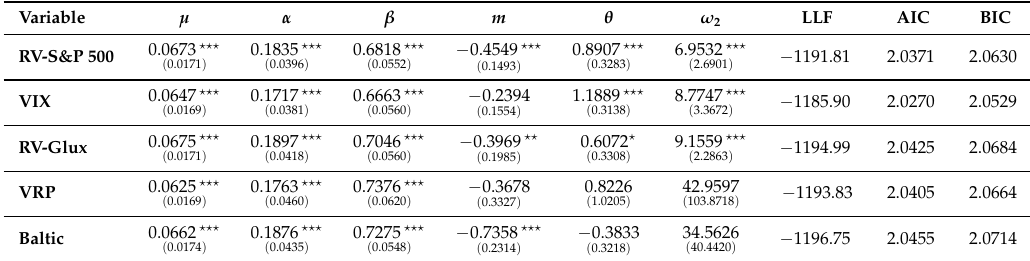
Table 4. GARCH-MIDAS for S&P 500.